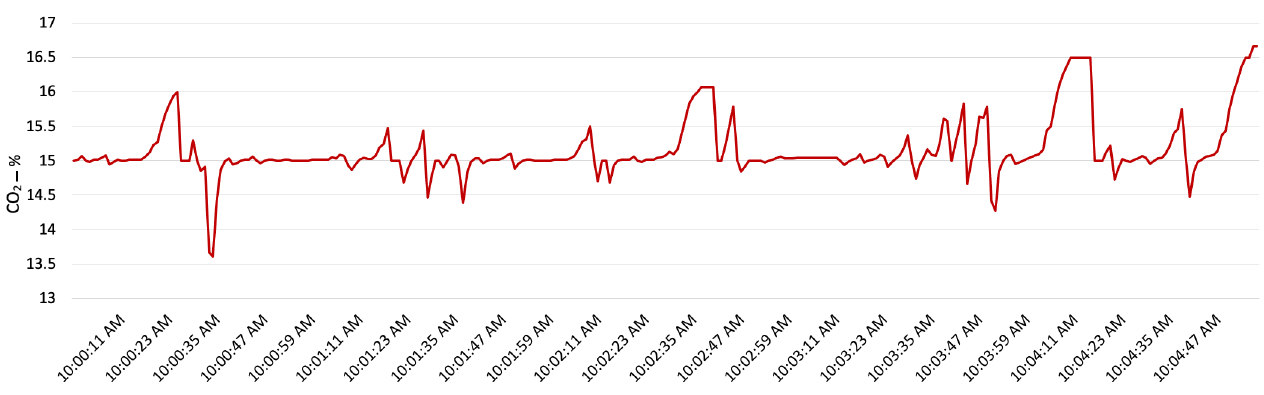
Figure 10. CO 2 percentage in emitted gas from the tailpipe.